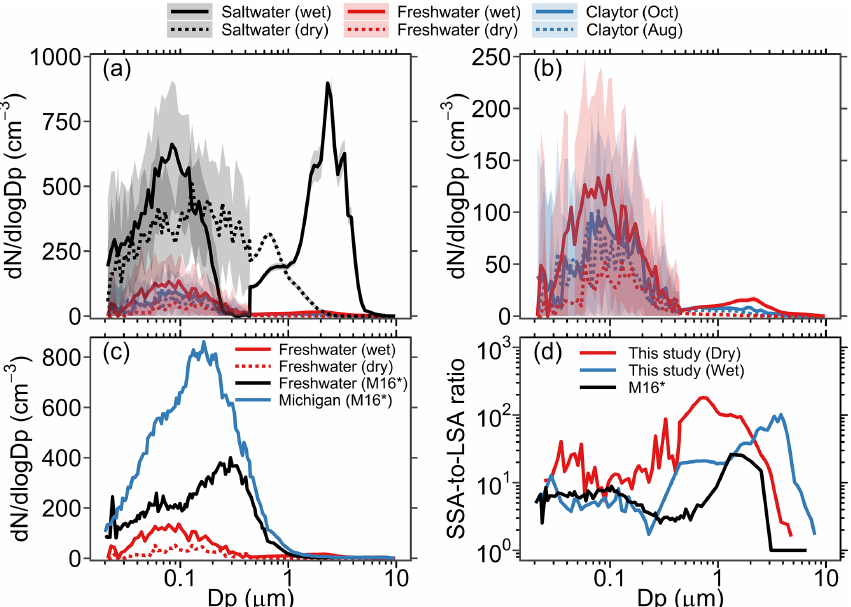
Figure 2. (a) Average aerosol size distribution generated in the MART using the synthetic freshwater, synthetic saltwater, and Claytor Lake water samples collected in October and August. Shaded areas represent ± 1 standard deviation. “Dry” and “wet” denote measurements made with and without a dryer, respectively. (b) A close-up of the average aerosol size distributions from the synthetic and Claytor Lake freshwater solutions. (c) LSA size distribution from synthetic freshwater (wet and dry) plotted along with LSA size distributions from synthetic and Lake Michigan freshwater from May et al. (2016). (d) Ratio of SSA-to-LSA aerosol size distributions produced in the MART (wet and dry) and that produced in the LSA generator of May et al. (2016). ∗ M16 denotes May et al.